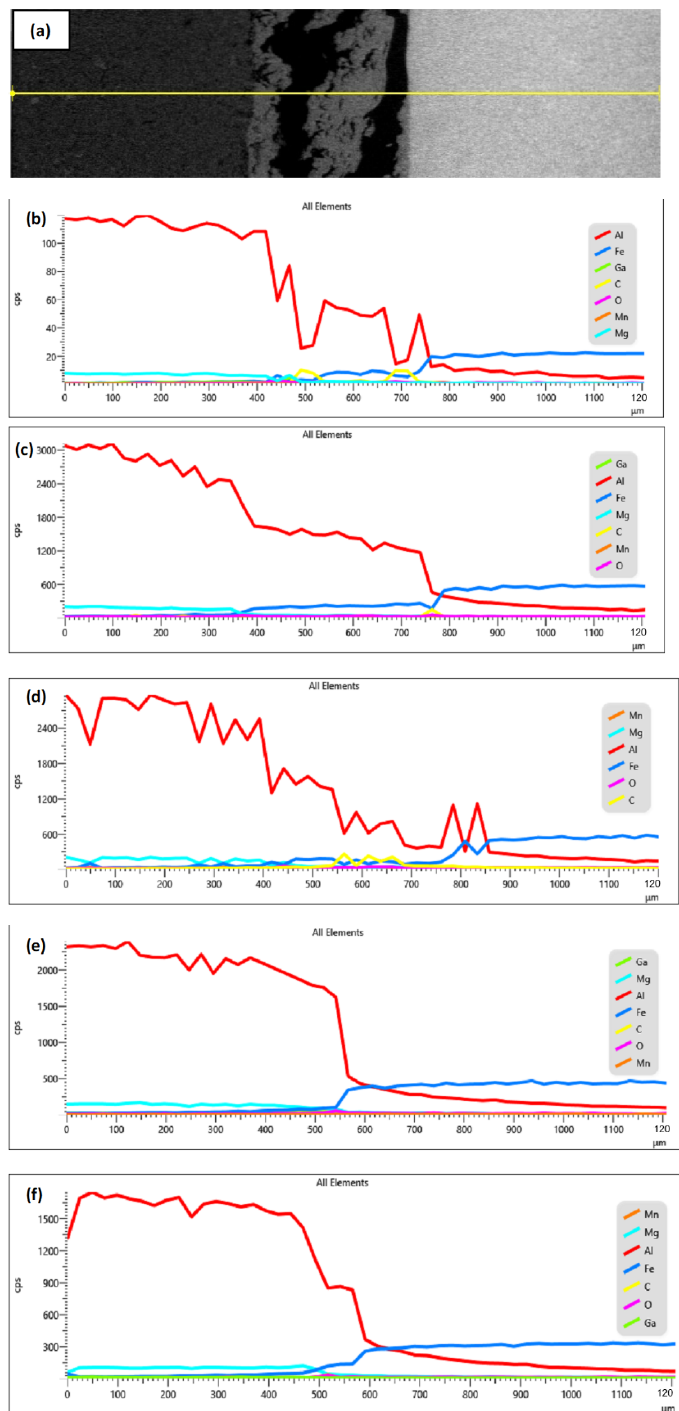
Figure 12. ( a ) Direction of EDX linescan; ( b ) Sample E; ( c ) Sample F; ( d ) Sample G; ( e ) Sample H; ( f ) Sample I.